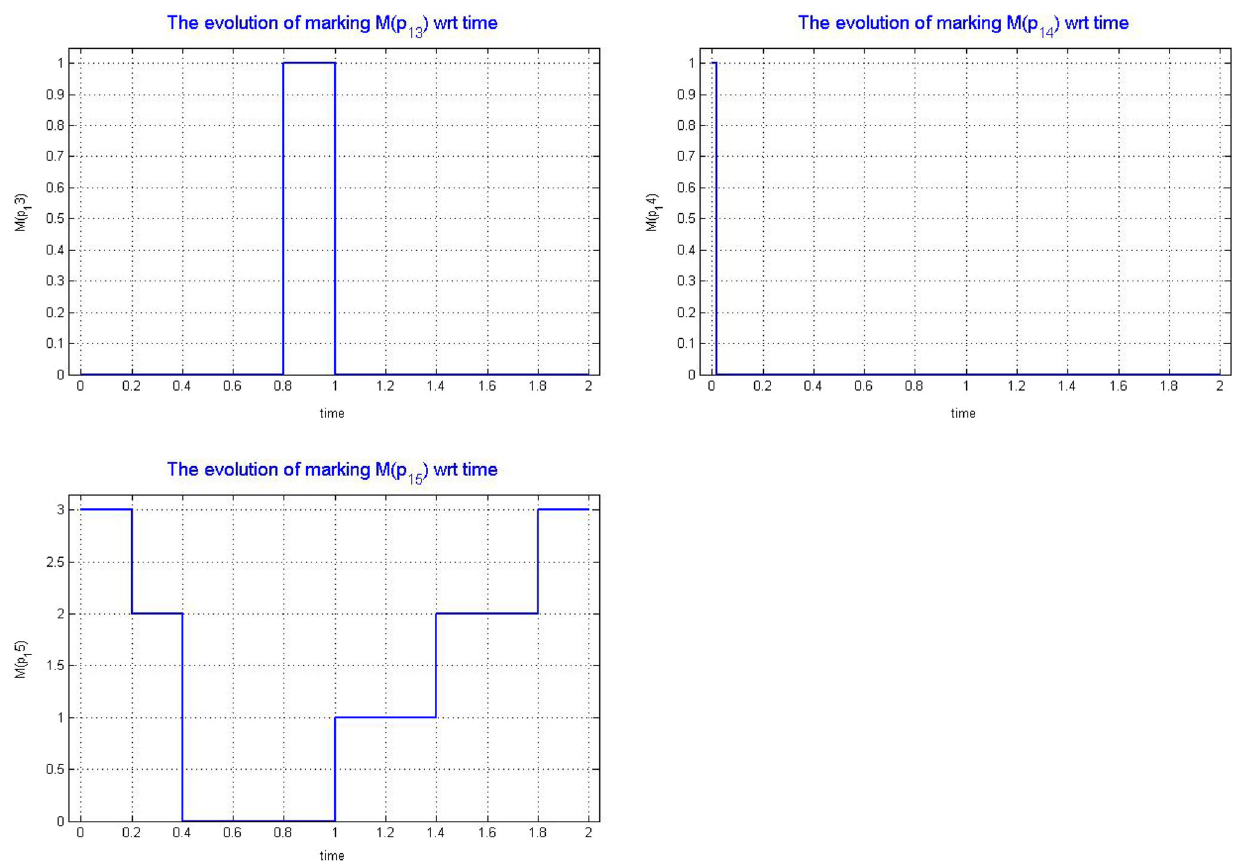
Fig. 12 The courses of marking the places p 13 − p 15 wrt. time. The place p 15 expresses the state (marking) of the supervisor